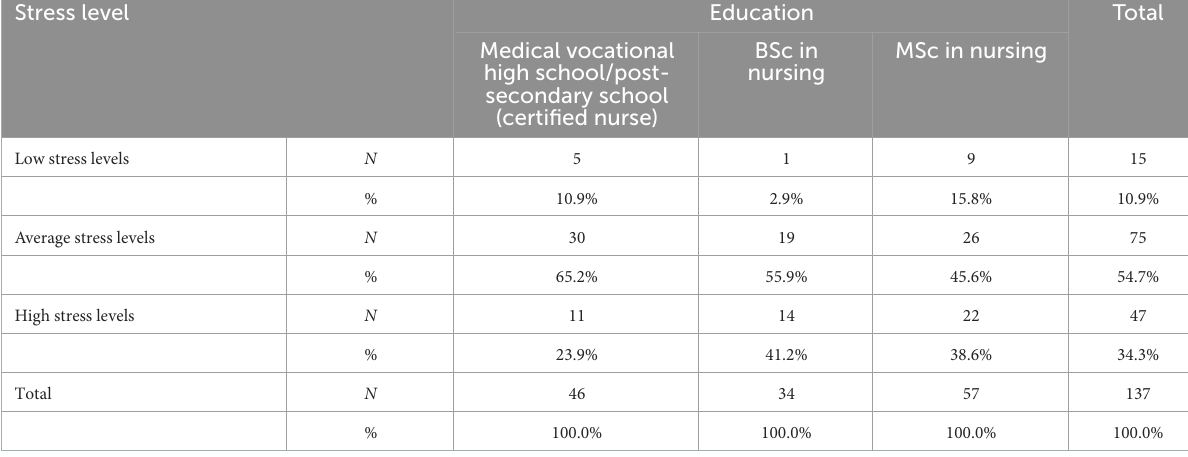
TABLE 4 Completed education and the level of perceived stress. Stress level